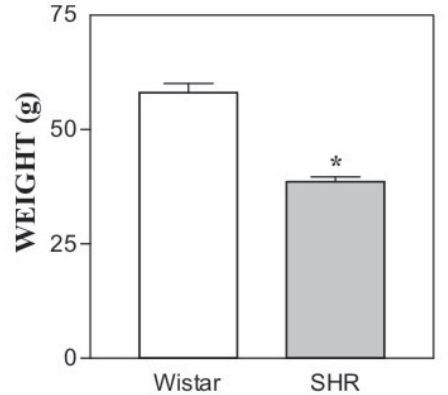
FIGURE 2 - Weight of Wistar offspring and SHR offspring. The bars represent the mean ± SEM of the weigh of Wistar offspring (n=74) and SHR offspring (n=94) at 30 days after birth. *Significant difference of weight between Wistar offspring and SHR offspring, at 30 days after birth (p<0,05 by unpaired t test between both groups)